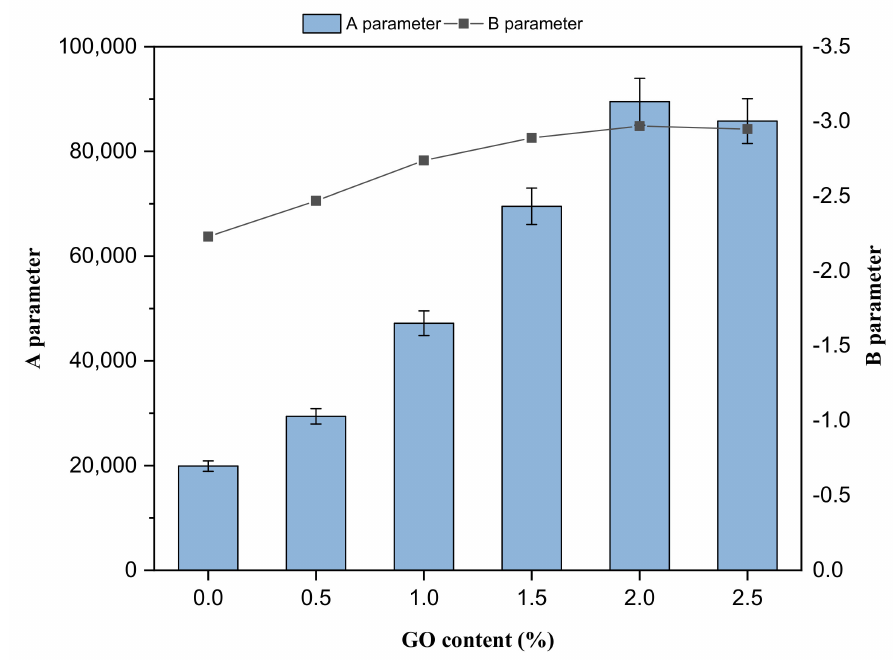
Figure 6. The A and B parameters of binders from linear amplitude sweep tests.